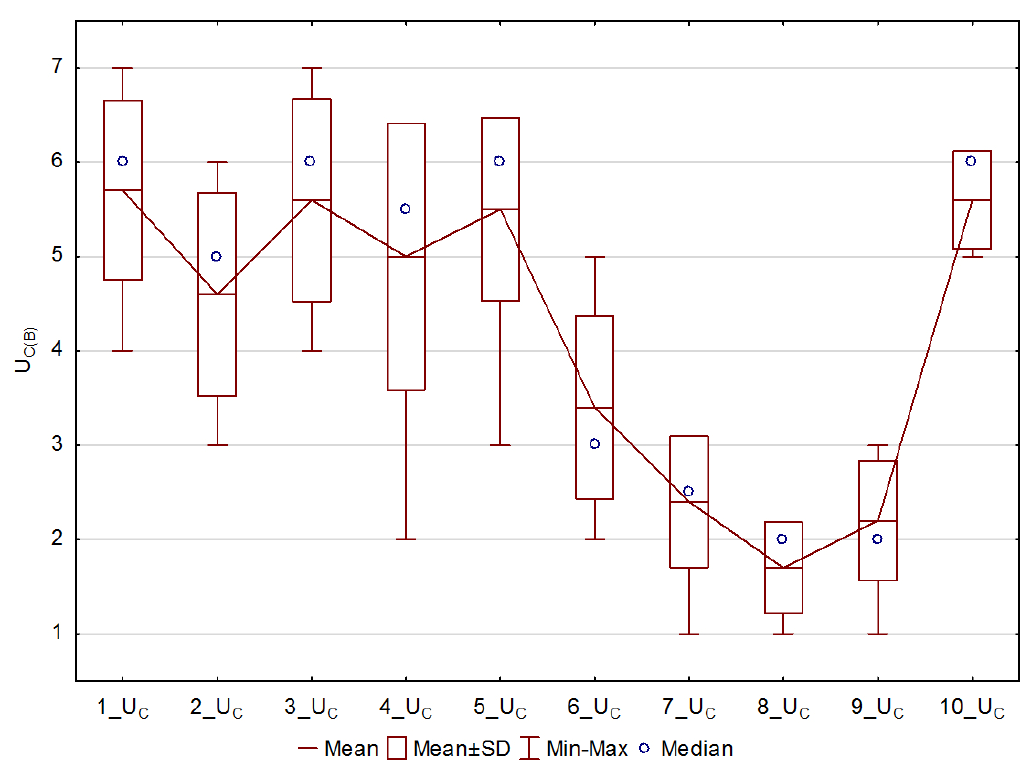
Figure 25. Ceiling uniformity perception for group B.